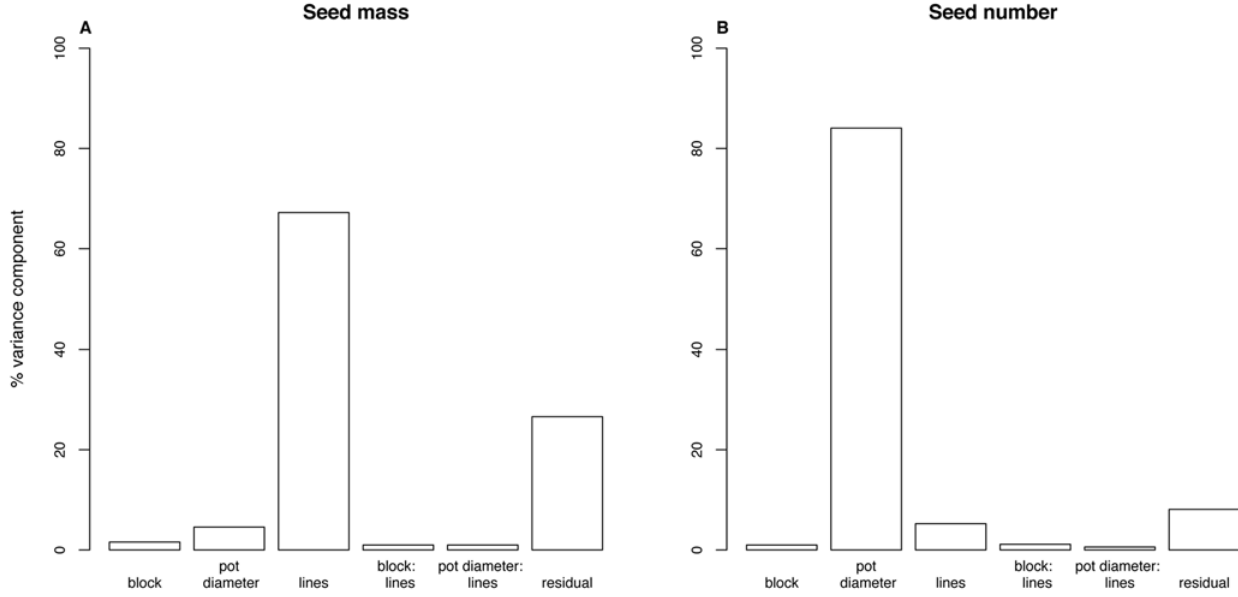
Figure 2. Results of a variance components analysis of harvested seed mass (A) and seed number (B). Variance components are expressed as percentages of the total in each case. Note that seed mass shows a large genetic component (variation among lines) whereas seed number shows a large environmental component (variation among pot sizes).